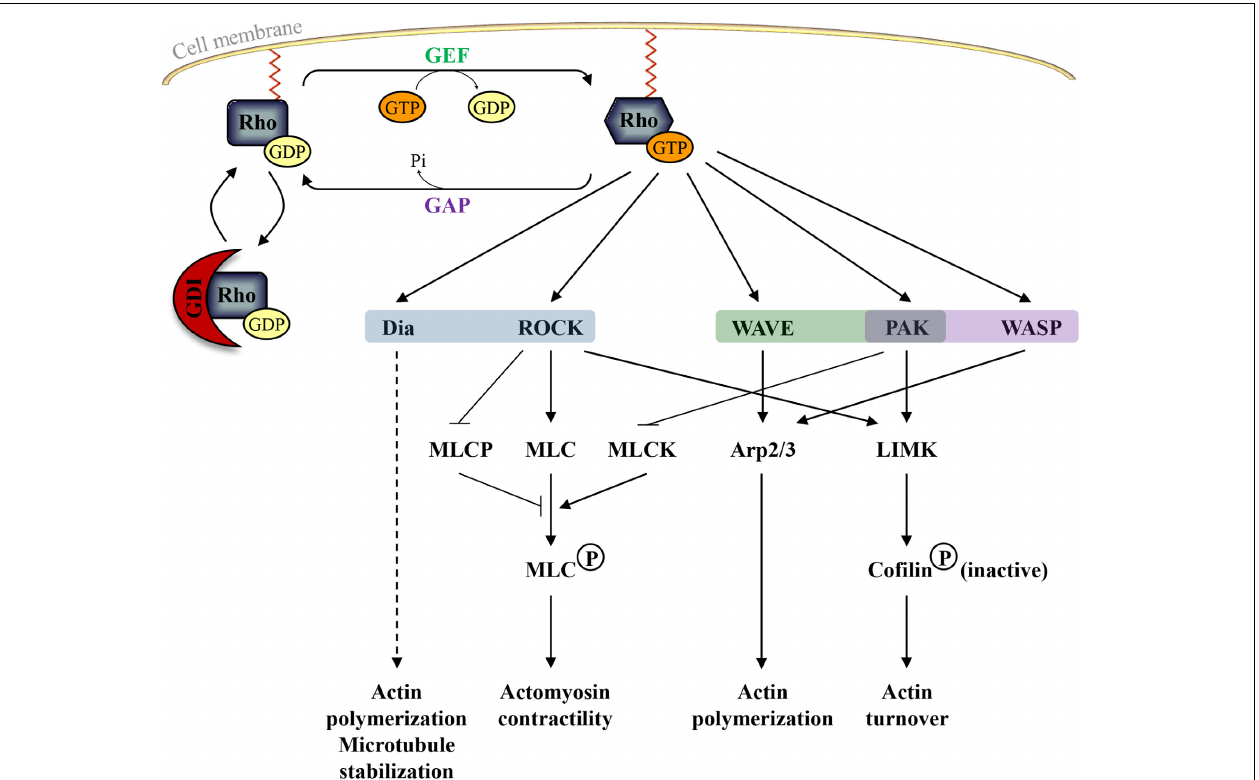
FIGURE 2 | The classical Rho GTPase cycle and the main pathways regulated by active RhoA (in blue), Rac1 (in green), and Cdc42 (in purple). Guanine nucleotide-exchange factors (GEFs) activate Rho GTPases by promoting the release of GDP and the binding of GTP whereas GTPase-activating proteins (GAPs) inactivate Rho GTPases by increasing the intrinsic GTPase activity of Rho proteins. Guanine nucleotide-dissociation inhibitors (GDIs) sequester RhoGTPase in their inactive state and protect